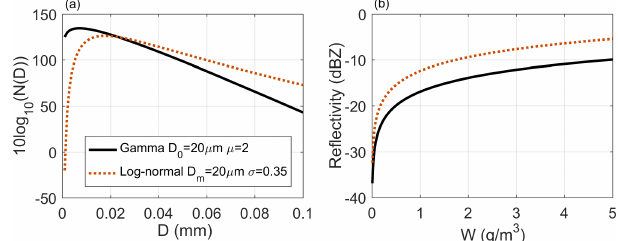
Figure 5. Impact of PSD models on radar reflectivity for cloud water. (a) Solid black line is for the gamma distribution: W = 1 (gm − 3 ), D 0 = 20µm, and µ = 2. Dotted red line is for the lognormal distribution: W = 1gm − 3 , D m = 20µm, and σ = 0 . 35. (b) Variation in the radar reflectivity with W and the PSD models, where the PSD models are from (a)